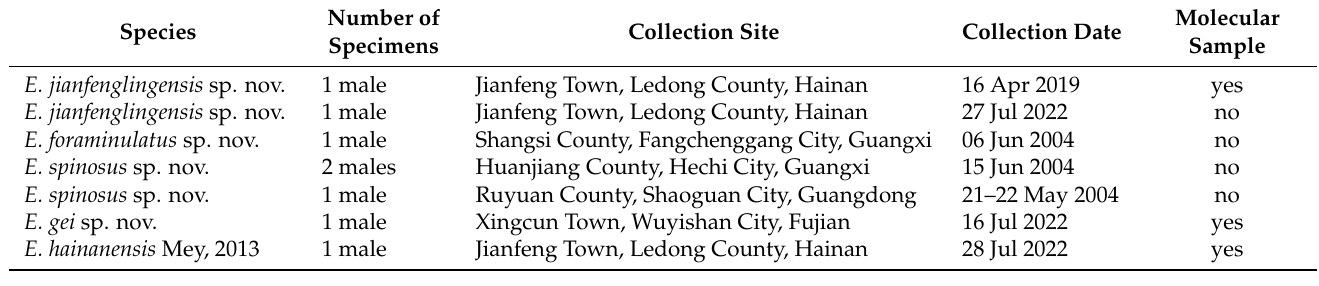
Table 2. Information on the collection of 8 specimens.